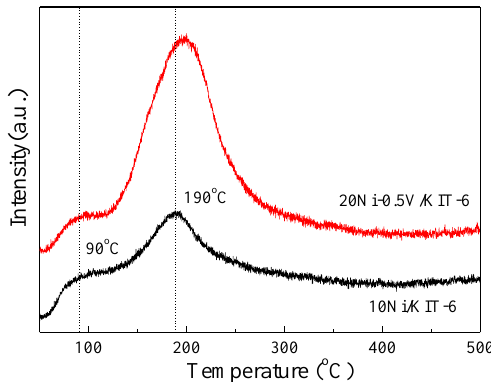
Figure 7. Carbon dioxide temperature-programmed desorption (CO 2 -TPD) profiles of 10Ni/KIT-6 and 20Ni-0.5V/KIT-6.